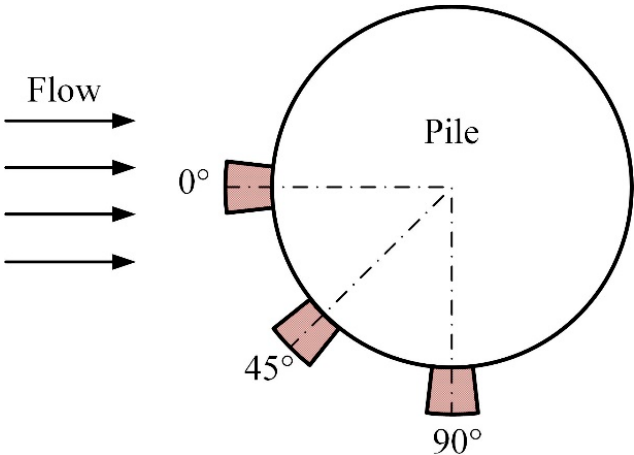
Figure 11. Schematic diagram of prismatic areas.